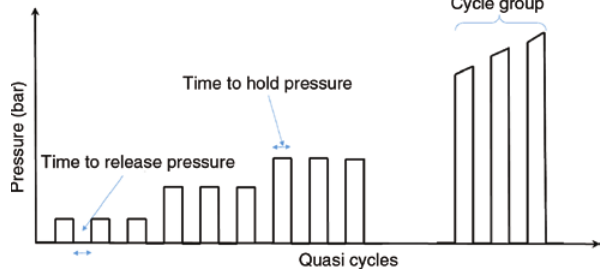
Figure 9: Representation of the cycles and cycle groups